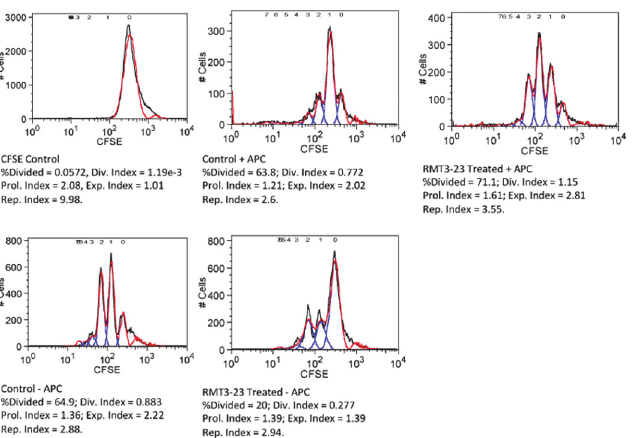
Fig 11. Effect of TIM-3 blockade on the suppressive function of uterine MDSC. Uterine MDSC were flow sorted from Control and RMT3-23 treated pregnant mice between GD10.5 to 12.5. The uMDSC were co cultured with CFSE stained CD4+ T cells from OT II mouse in presence of allogeneic CD90 - APC and OVA 323- 339 peptide. Following 72h. of incubation cell proliferation was determined by CFSE dilution using a flow cytometer. Data represents 2 experiments.